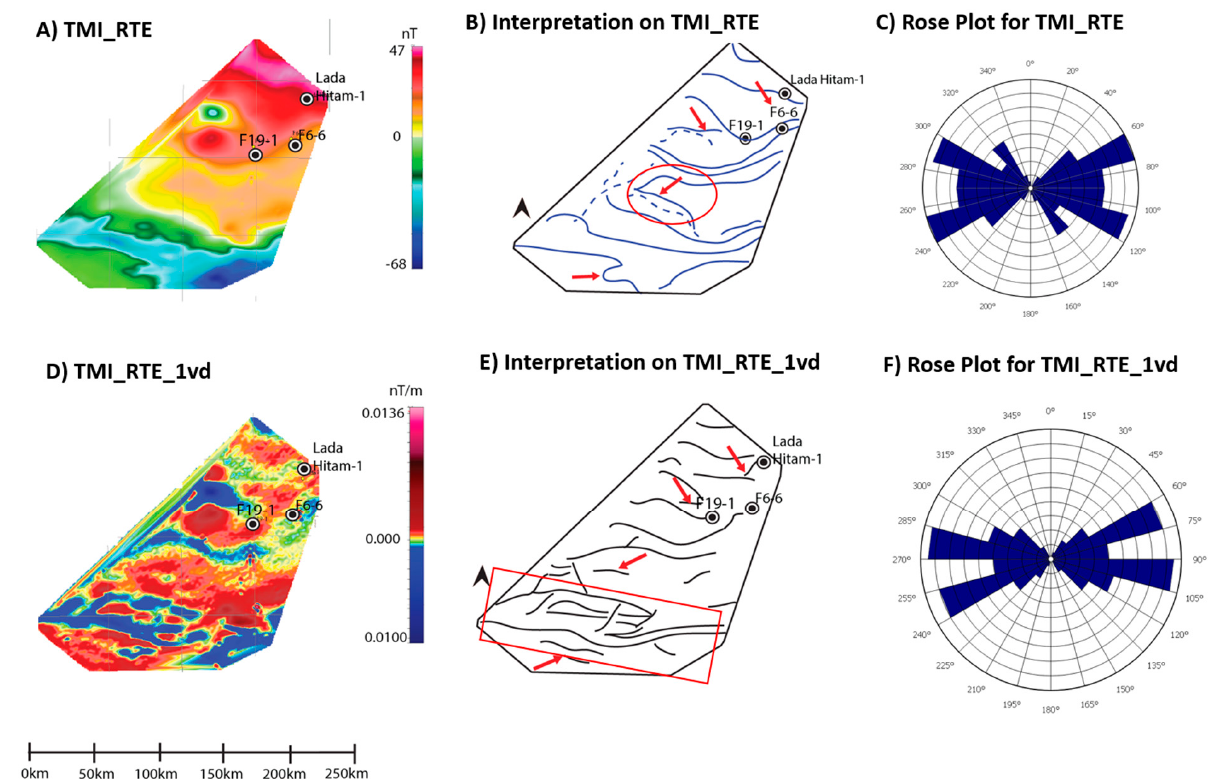
Figure 5. ( A ) Total Magnetic Intensity Reduce to Equator (TMI_RTE) represents magnetic basement. ( B ) Lineaments/Structural trend interpretation on TMI_RTE. ( C ) Rose plot diagram for interpreted structural trend in ( B ). The eclipse on ( B ) is representing possible folding structures on the basement (obvious anticline closure on TMI_RTE. ( D) First derivative of TMI_RTE known as TMI_RTE_1vd represents section shallower than the basement. ( E ) Lineaments/ Structural trend interpretation on TMI_RTE_1vd. ( F ) Rose plot diagram for interpreted structural trend in ( E ). Red arrows are pointing to the structural trends that are more prominent in either TMI_RTE data and rectangle in ( E ) is highlighting the complex faults within the low magnetic zone in the south of the area.